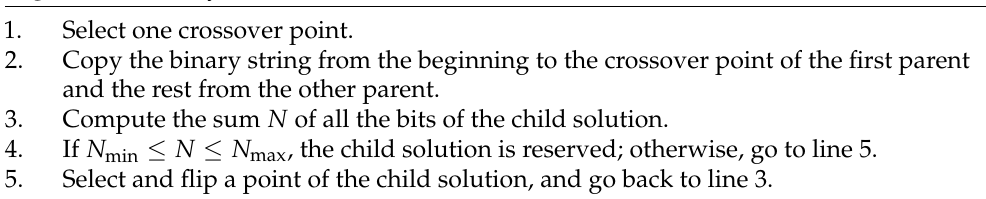
Algorithm 1 Binary constrained crossover.